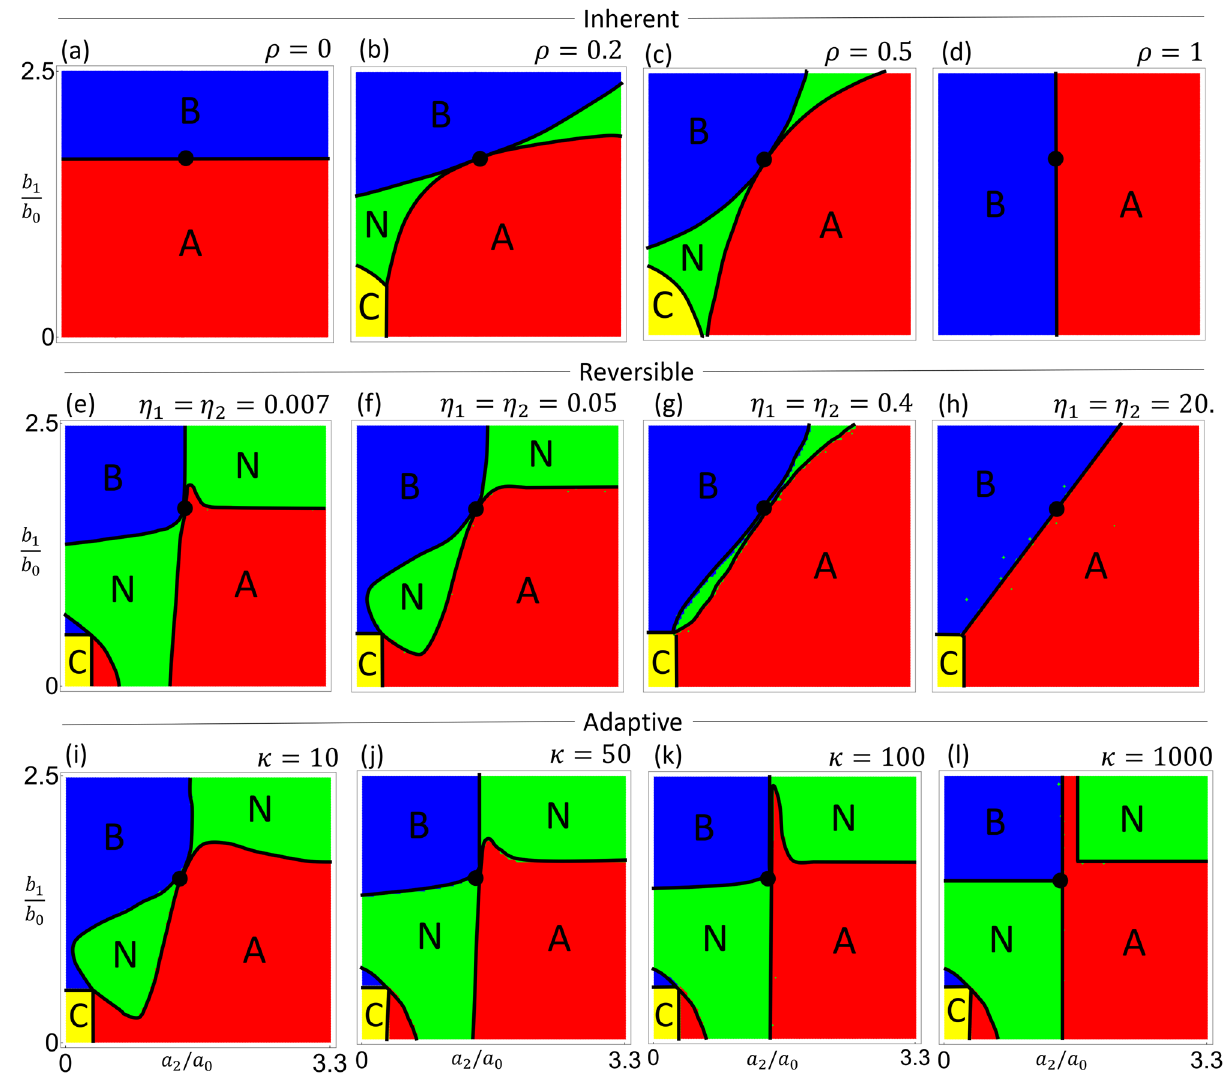
Figure 4. Phase diagrams showing regions of parameter space identified by the stable equilibrium points. Yellow region represents P C (predators A , B both extinct), red represents P A ( A excludes B ), blue represents P B ( B excludes A ), and green represents P N ( A , B coexist). The middle point (black dot) is where the preferences of the two predators are identical, a 2 / a 0 = b 2 / b 0 and b 1 / b 0 = a 1 / a 0 . The coexistence phase appears in all